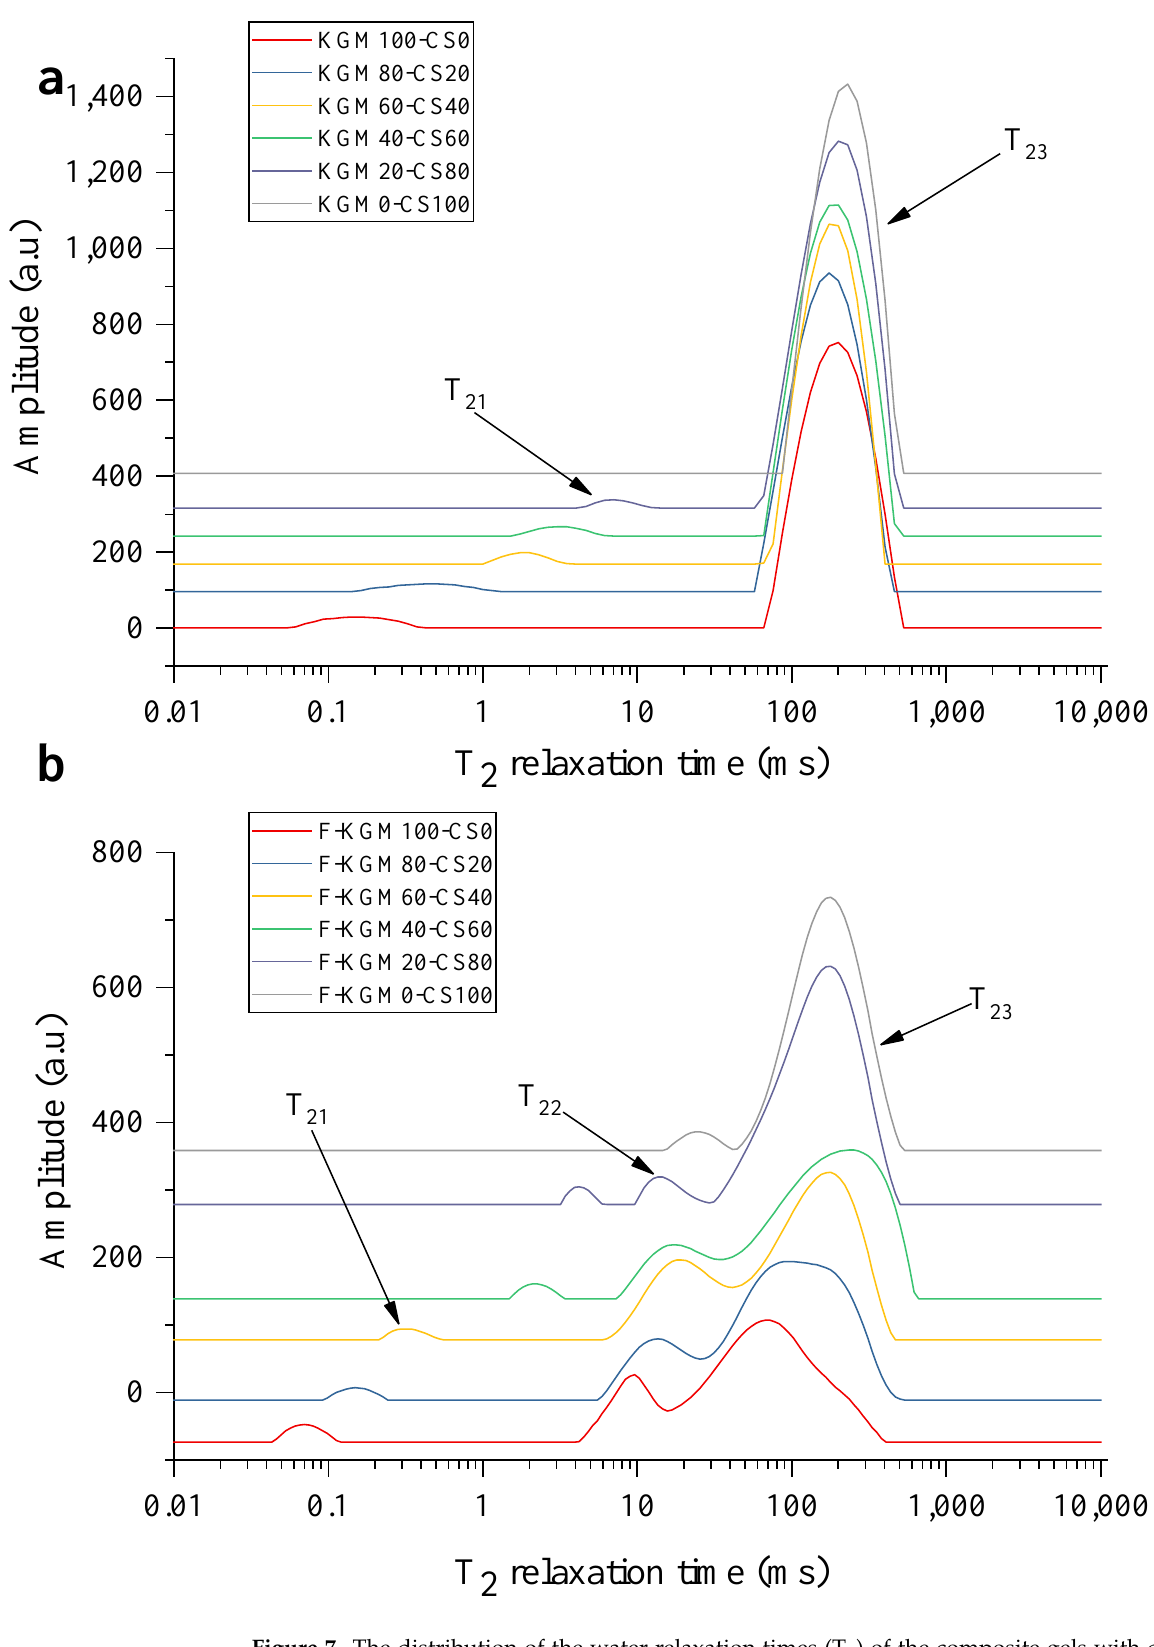
Figure 7. The distribution of the water relaxation times (T 2 ) of the composite gels with different KGM/starch ratios: ( a ) KGM–CS gels; ( b ) F–KGM–CS gels.